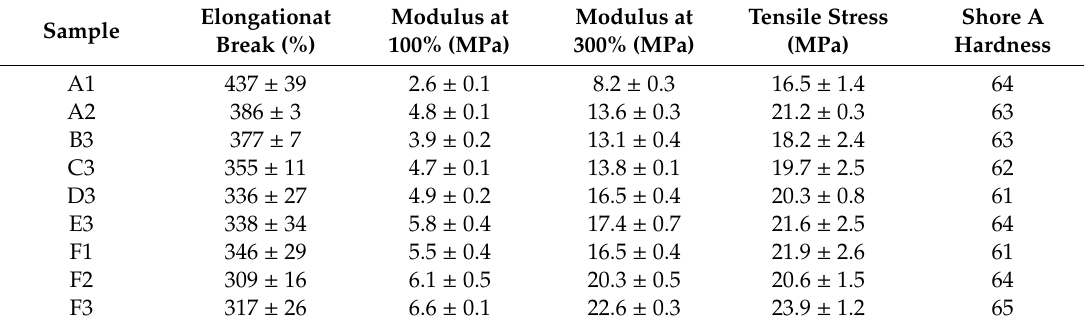
Table 6. Mechanical properties of silica/SSBR/BR composites.